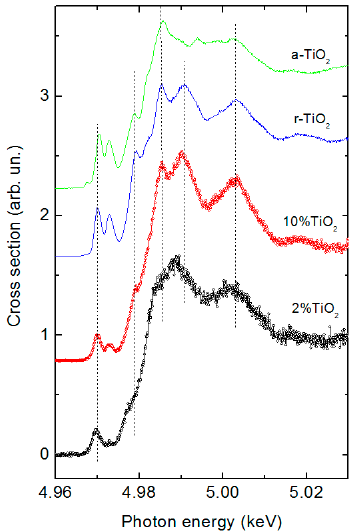
Figure 5. Ti K-edge XANES spectra of 2% a 10% Ti(IV)-modified hematite sample using rutile and anatase (TiO 2 ) as references.